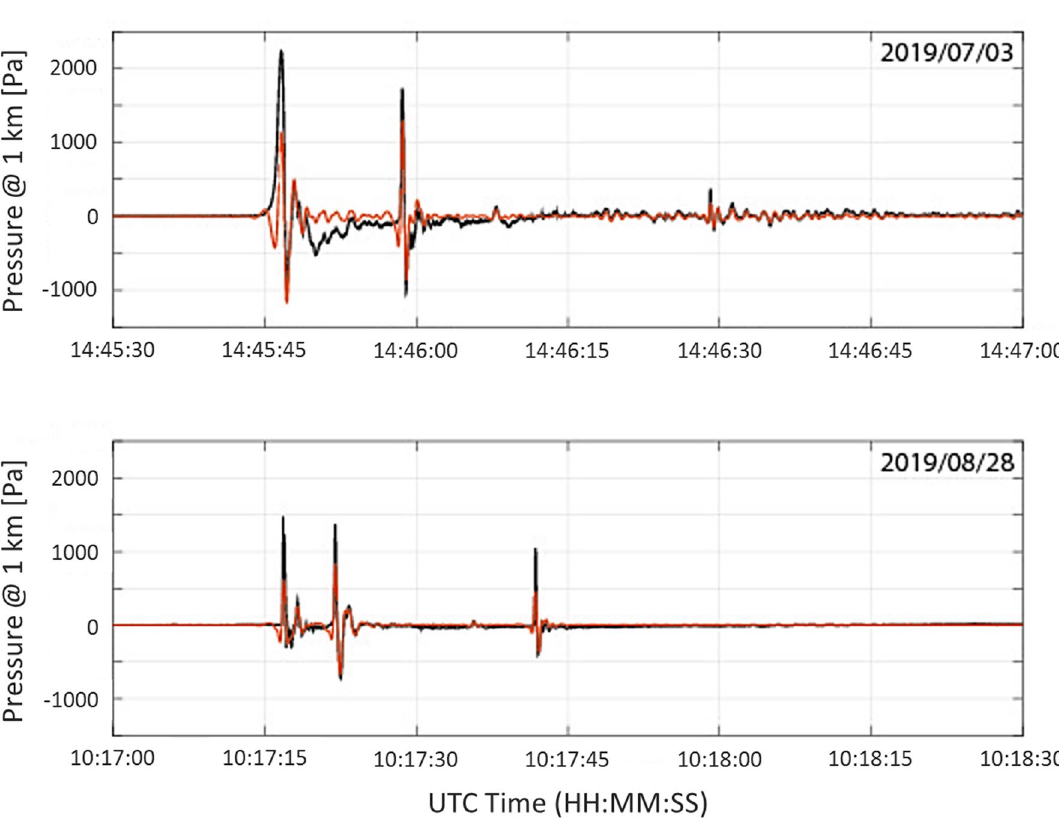
Figure 2. Raw infrasound pressure recorded at Stromboli for the July (top) and August (bottom) events reduced at 1 km from the source (black curve). Peak amplitudes of the first arrival reduce down to ~ 1300 and ~ 700 Pa respectively once band-pass filtered in the 0.5–2 Hz frequency band (red